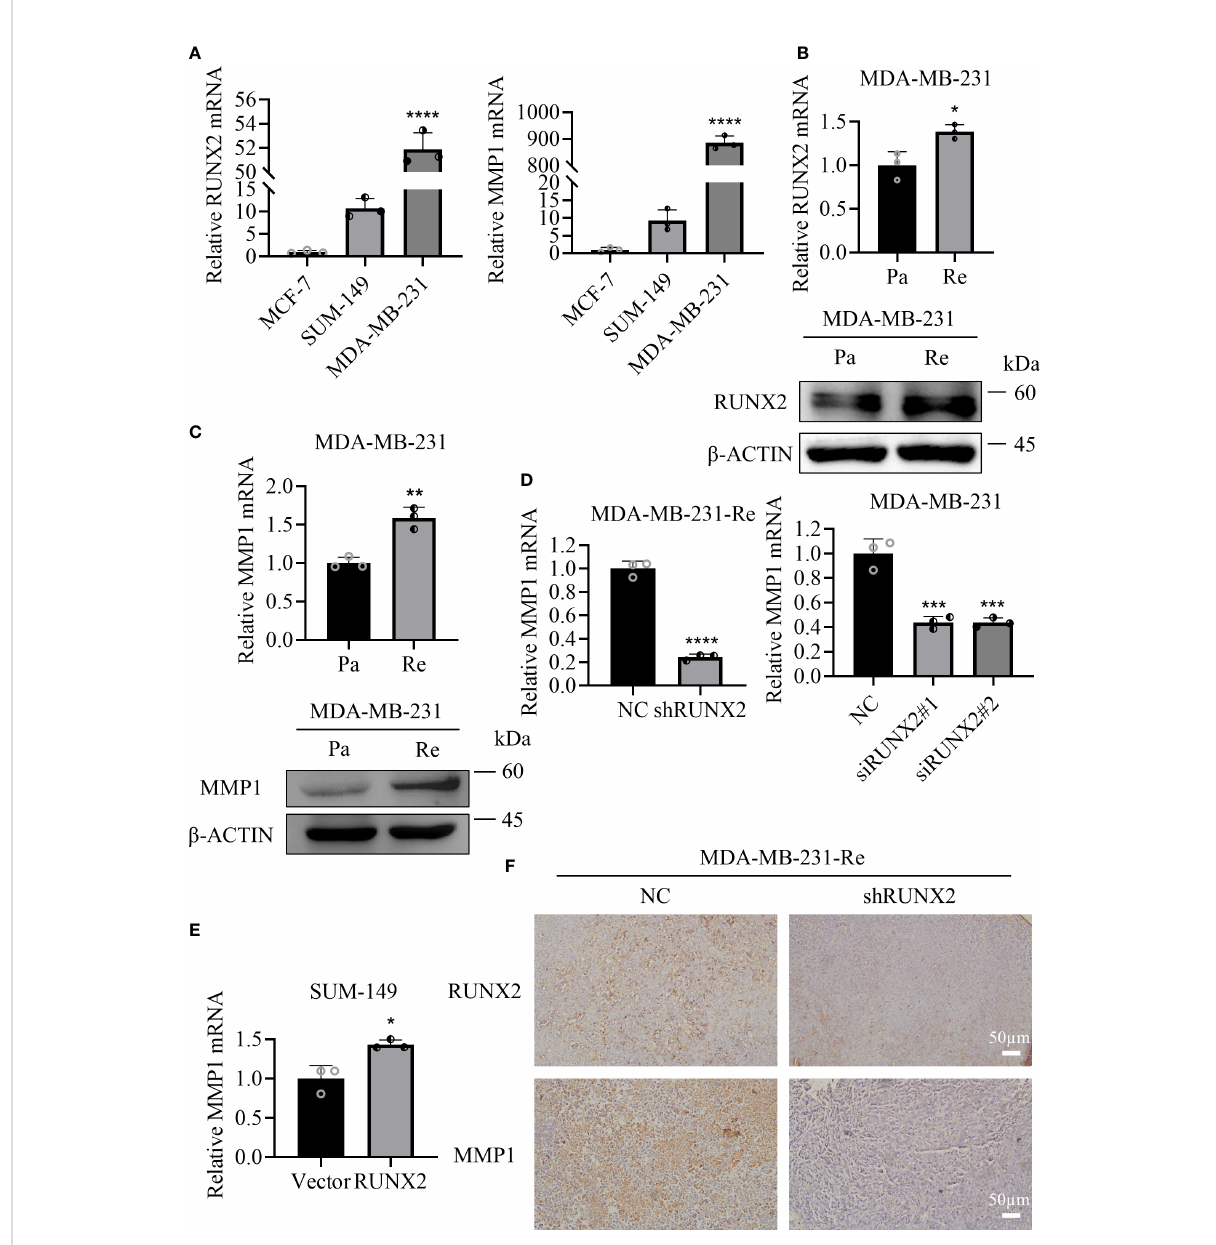
FIGURE 8 MMP1 and RUNX2 showed positively correlation in relative mRNA and protein expression. (A) qRT-PCR analysis of the expression of RUNX2 and MMP1 in various breast cancer cell lines. (B, C) qRT-PCR and western-blotting analyses of RUNX2 (B) and MMP1 (C) expression in